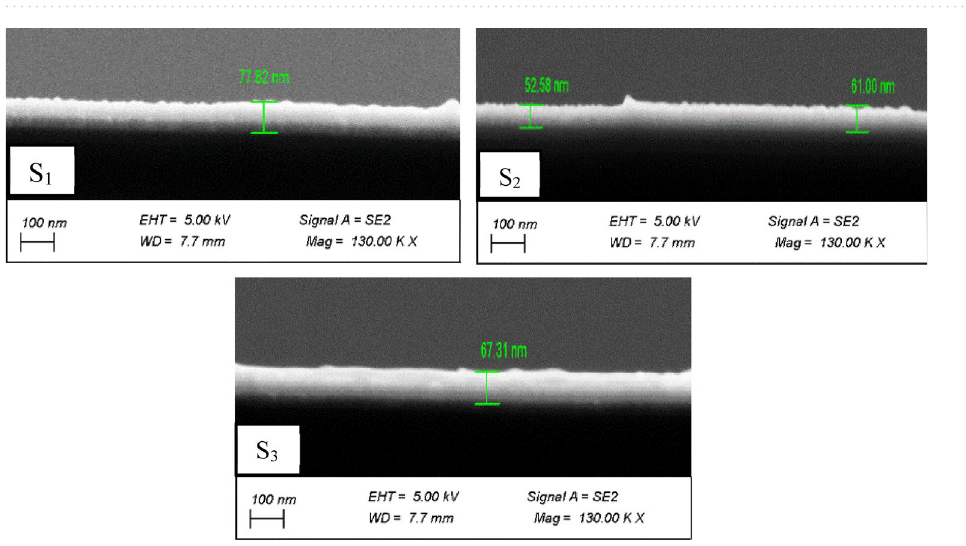
Figure 2. FESEM cross section diagram of